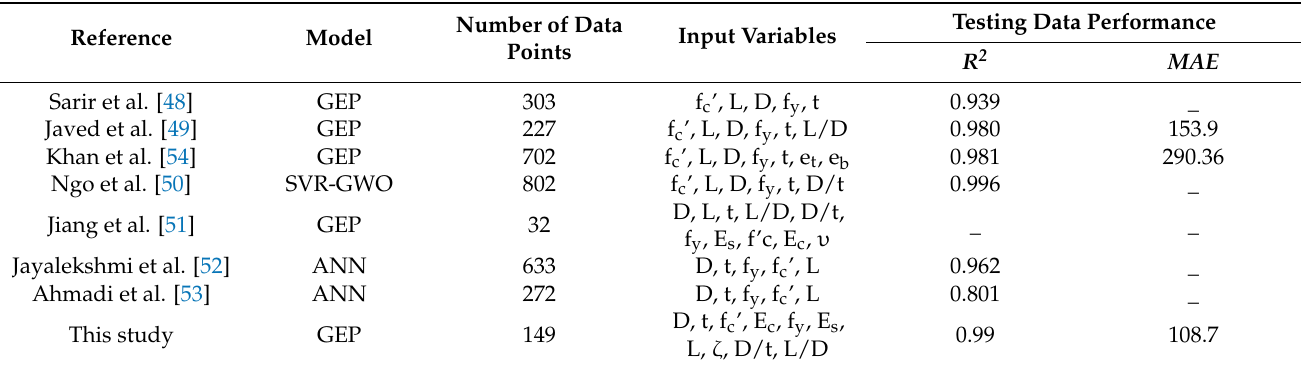
Table 1. Summary of the previous studies in the literature pertaining to prediction of axial capacity of